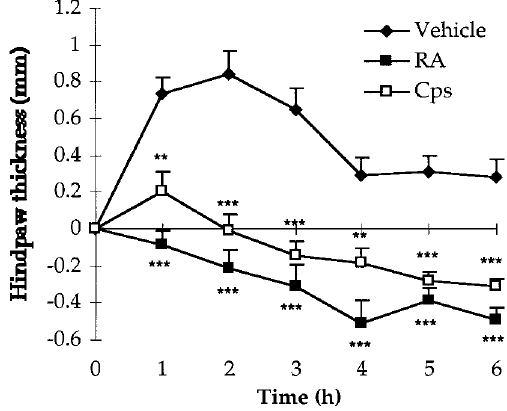
FIG. 2. Carrageenan-induced oedema of mouse paw. Effects of 8-day treatment with ricinoleic acid (RA, 0.9mg/mouse) or capsaicin (Cps, 0.09mg/mouse). Data are mean ± standard error (SE). n = 5–8 for each group. ** p < 0.01; *** p < 0.001 versus vehicle